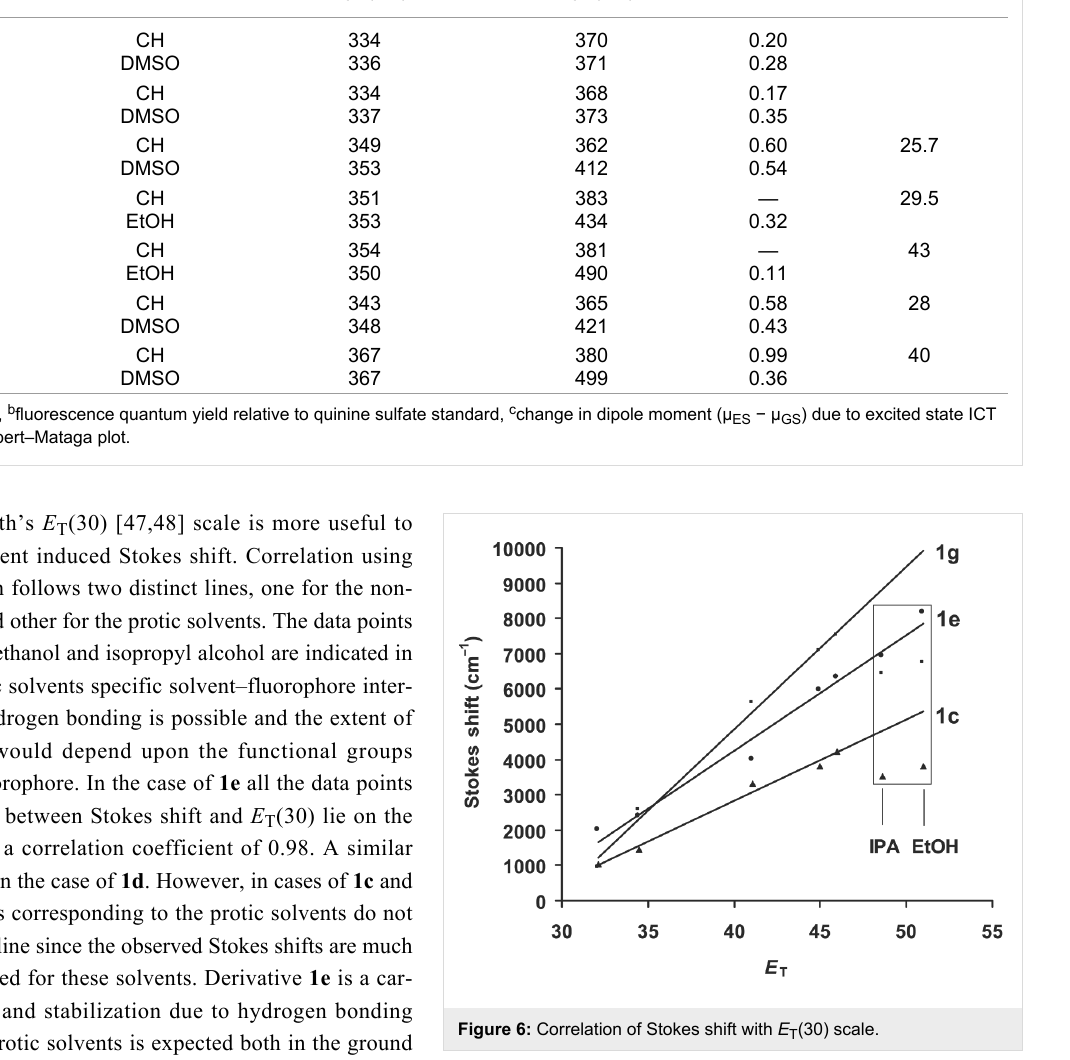
Table 1: Representative absorption, emission and fluorescence quantum yield data. Substrate